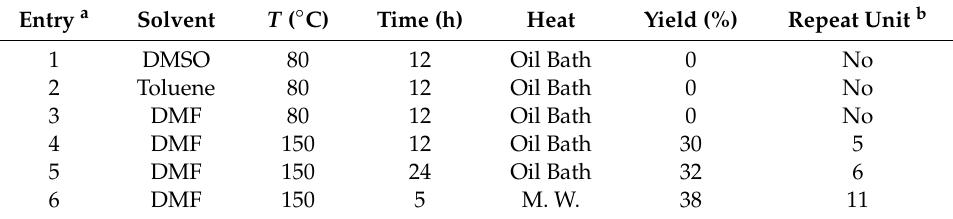
Table 1. Optimization of the Ullmann polymerization of